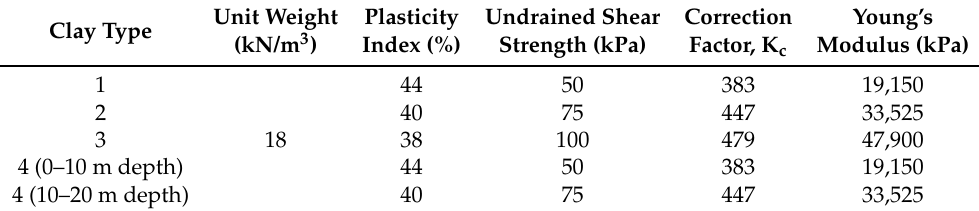
Table 3. Soil properties for the cyclic behaviour models (after